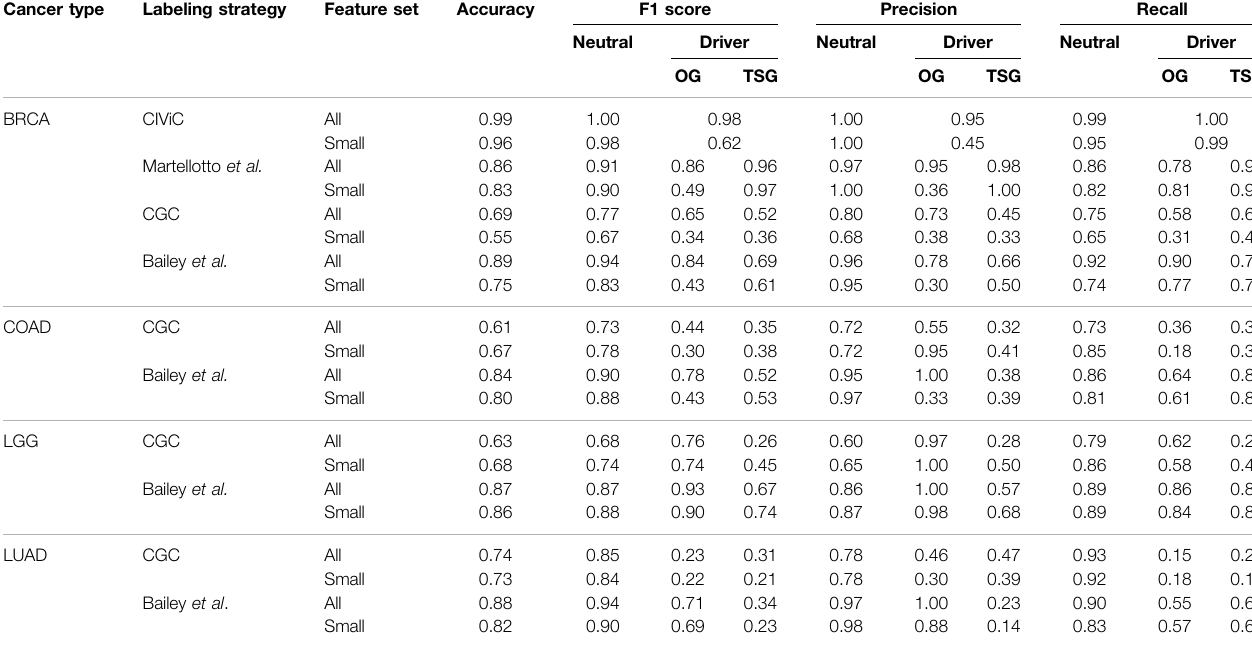
TABLE 1 | Classi fi cation metrics for best SNV models. Cancer type Labeling strategy Feature set Accuracy F1 score Precision Recall Neutral Driver Neutral Driver Neutral Driver OG TSG OG BRCA CIViC All